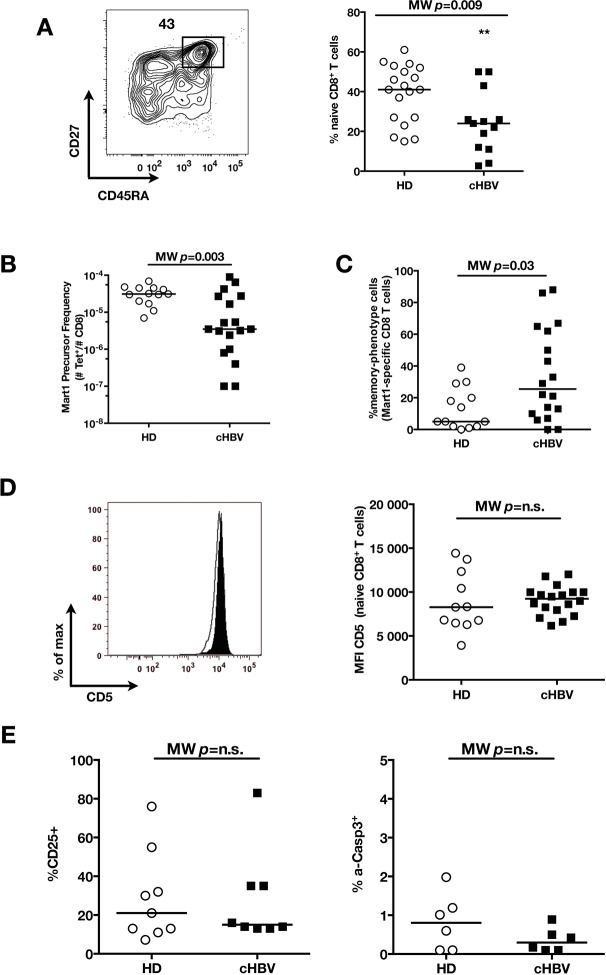
Distinct perturbation of naïve CD8+ T cell repertoire during chronic HBV infection.(A) Representative example of CD45RA+CD27+ naïve CD8+ compartment in one cHBV patient, and percentages in multiple HD and cHBV donors. Absolute numbers could not be calculated in this cohort where only white blood cells counts were evaluated at the time of their sampling – and not lymphocyte numbers. (B) Mart1 precursor frequency in multiple HD and cHBV donors. (C) Percentages of memory-phenotype Mart1-specific T cells in multiple HD and cHBV donors. (D) Representative histograms of CD5 on naïve CD8+ T cells from one HD (white) and one cHBV patient (black), and MFI of CD5 on naïve CD8+ T cells from HD and cHBV patients. (E) Percentages of p-ERK and CD25-positive cells in naïve CD8+ T cells from HD and cHBV patients 24 hr after CD3/CD28 stimulation.